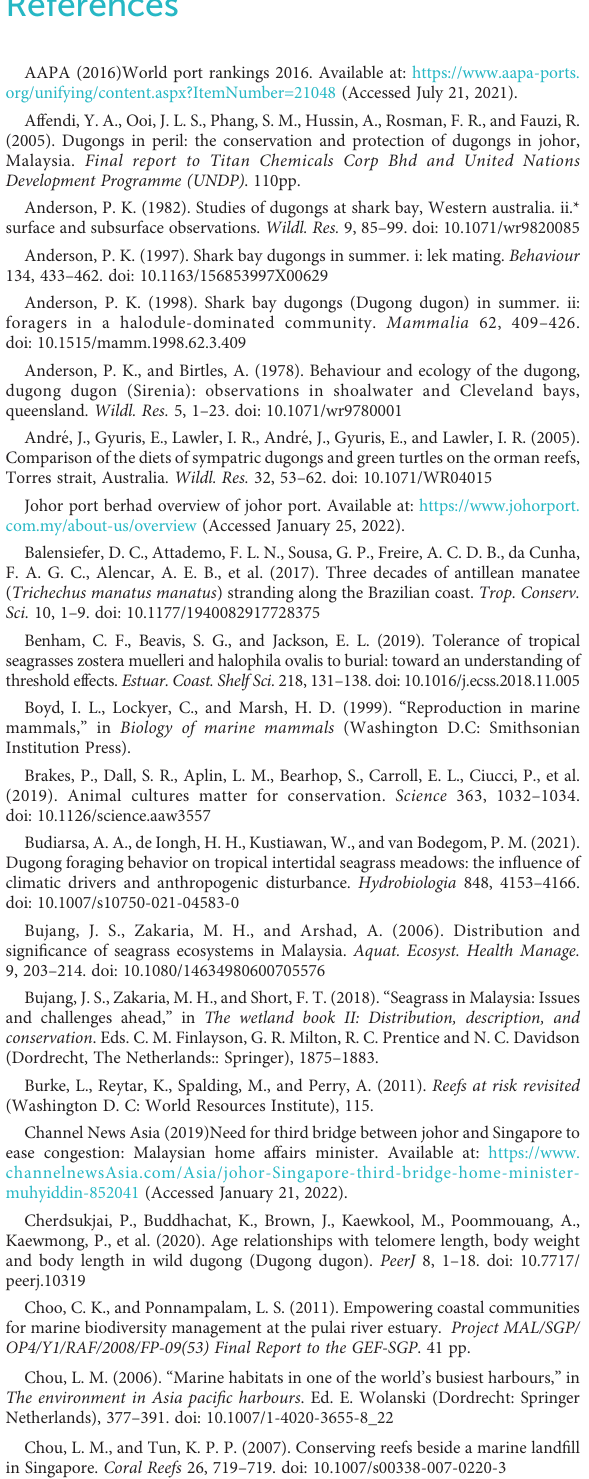
SUPPLEMENTARY FIGURE 3 Dimensions of 107 dugong feeding trails found across fi ve study sites in the Johor Strait and Singapore